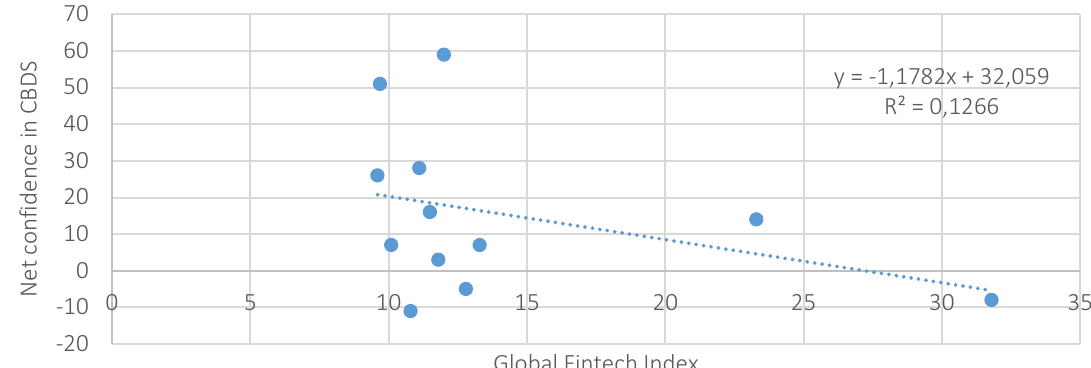
Figure C1. Confidence in CBDC and innovations